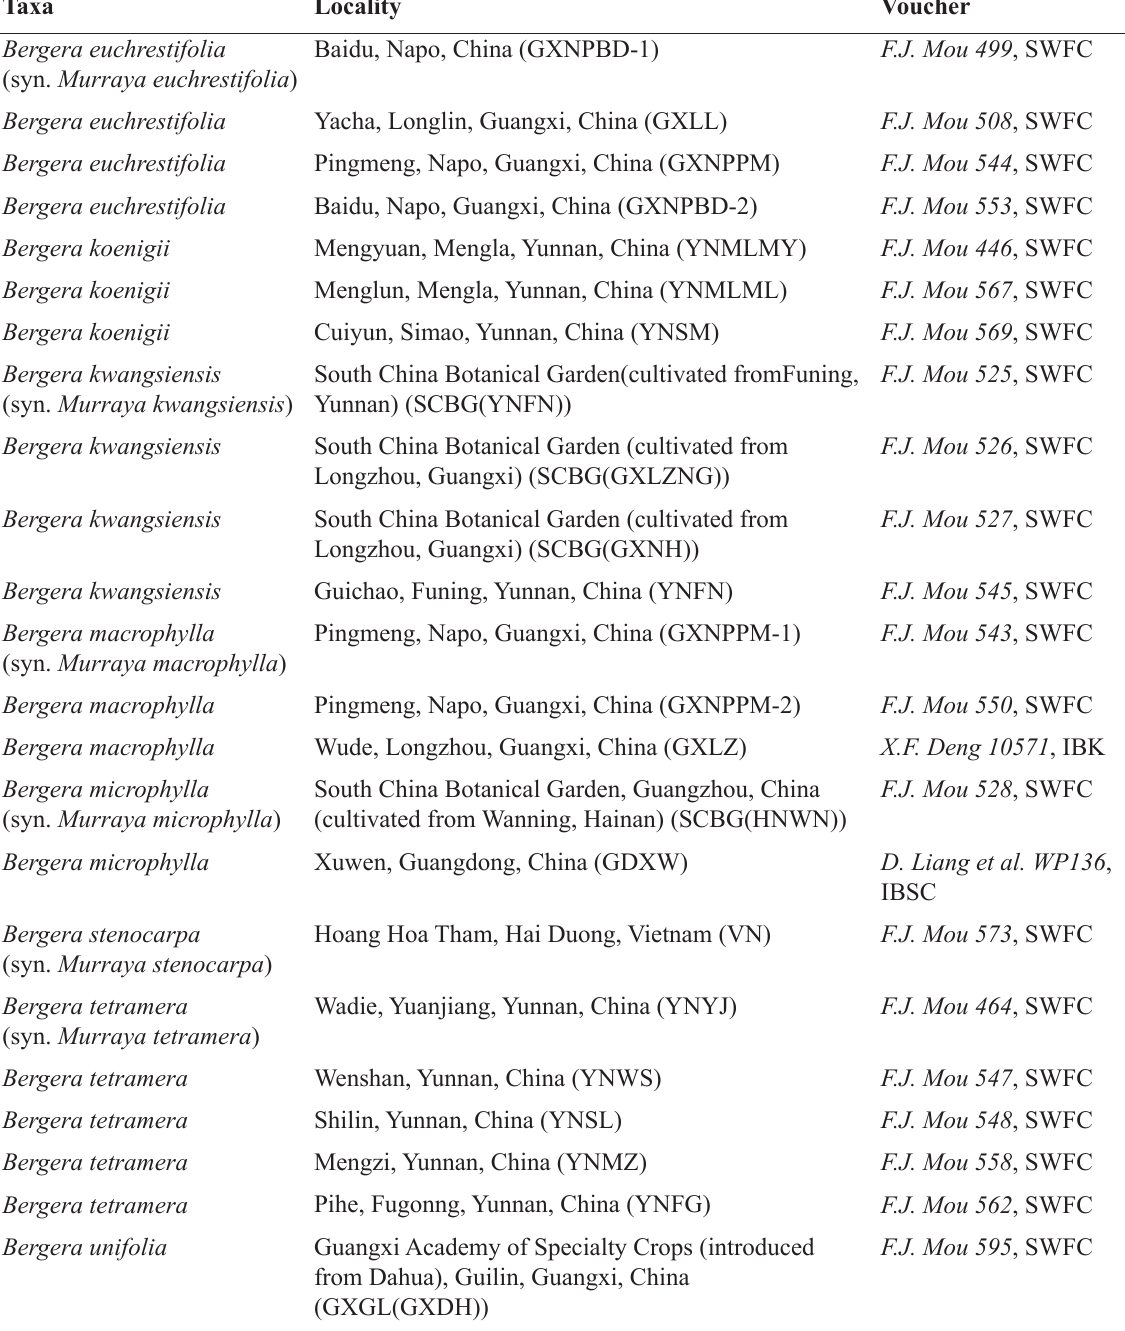
Table 2. Voucher information of Bergera J.Koenig ex L. and Murraya J.Koenig ex L. species in phylogenic